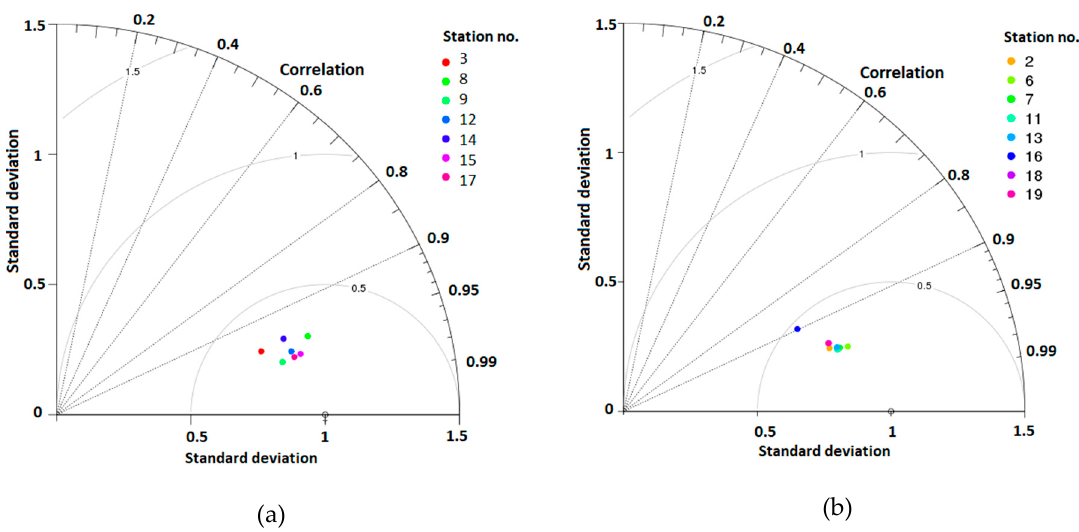
Figure 2. Taylor diagram for forecast air temperature for ( a ) mountain and hill peaks and ( b ) valley bottoms for the period 1 January to 30 April 2017.